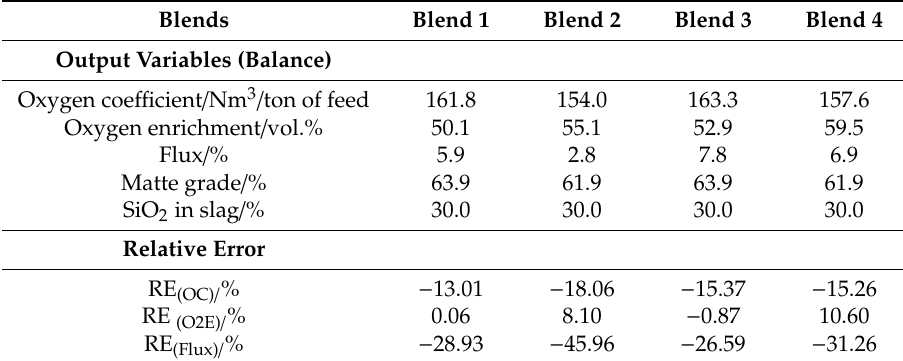
Table 14. Process balance results. Output variables and relative error (RE) estimation. OC (oxygen the expression “100 × (model values − industrial values) / industrial